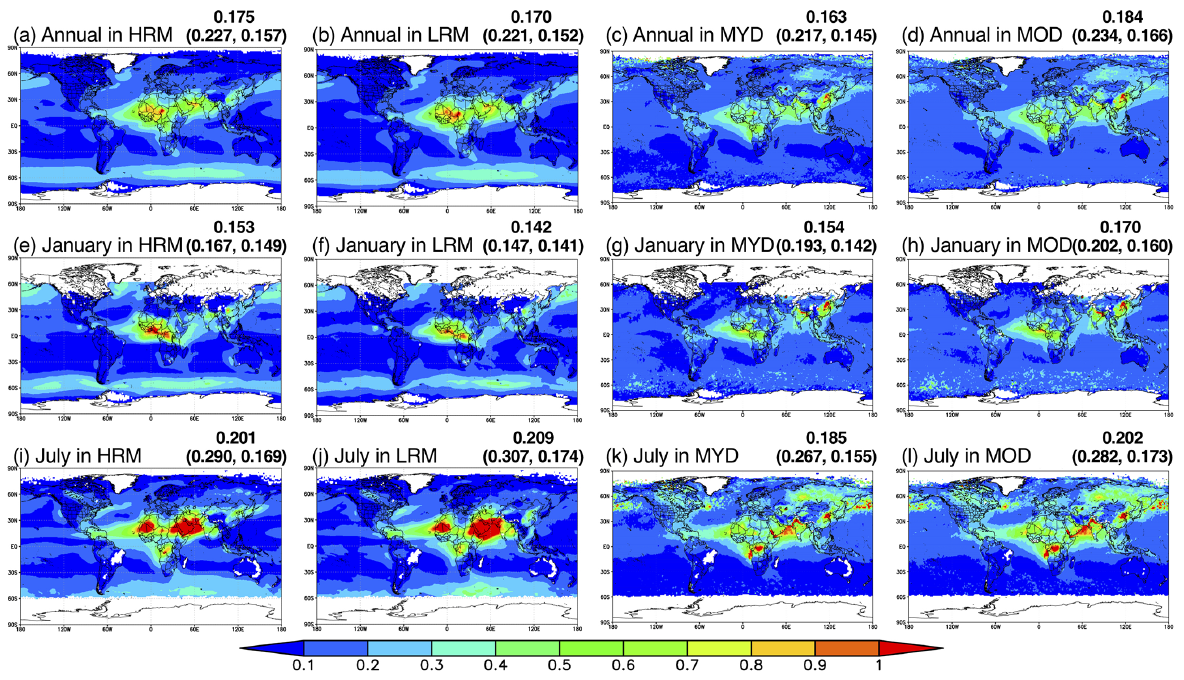
Figure 5. Global distributions of the annual, January and July averages of the AOT simulated by the HRM and LRM and retrieved from MODIS/Aqua (MYD) and MODIS/Terra (MOD). The model results for both the HRM and LRM are horizontally interpolated onto the MODIS grids (1 ◦ × 1 ◦ ). The numbers shown in the upper-right corner in each panel represent the annual and semi-global averages (60 ◦ S– 60 ◦ N); those in brackets represent the global land and ocean